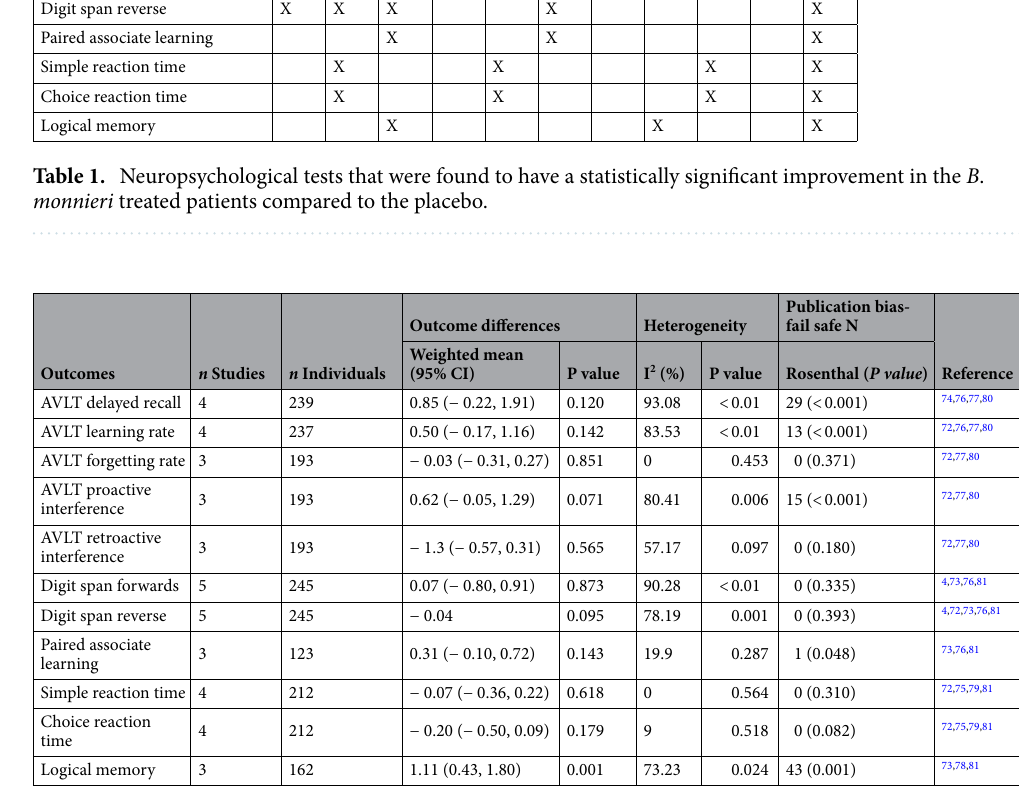
Table 2. Meta-analysis for the effect of B . monnieri on memory and attention in healthy people.